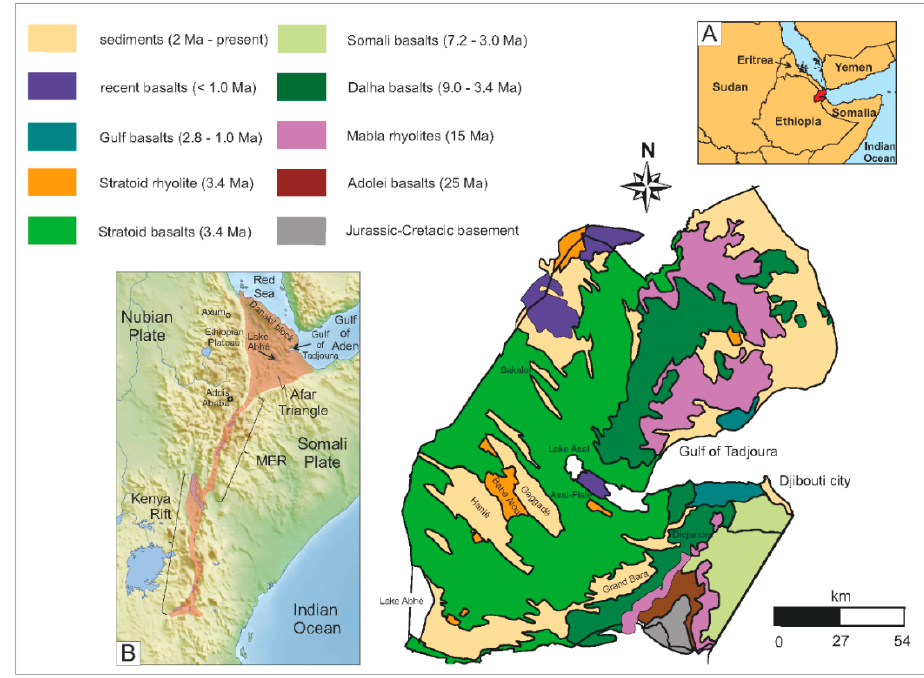
Figure 1. A schematic geological map of the Republic of Djibouti (modified after [9]). Inset A: location of the Republic of Djibouti (red) in the Horn of Africa. Inset B: a subdivision of the East African Rift System (light red; modified from [10]). The Hanlé and Gaggadé plains are the location at which the water samples were collected in this study. Details of the location at which the samples were collected are furnished in the Supplementary File S1 (a Google Earth *.kmz file).